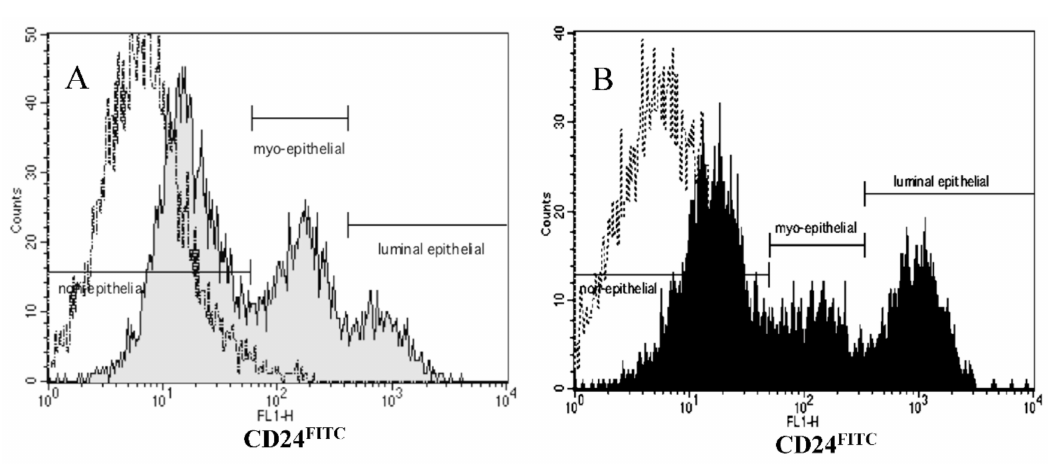
Figure 1. Representative flow cytometer histograms of mammary epithelial cell preparations for wildtype ( A ; grey) and fat-1 ( B ; black) mice. ( A , B ), epithelial cell populations determined by CD24 FITC staining intensity after gating out CD45PE + cells. Rat IgG2b FITC isotype control shown in black dotted